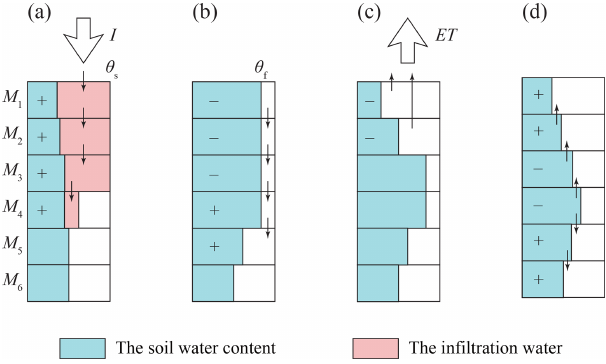
Figure A1. The schematic procedures of UBMOD with (a) the al- location of the infiltration water, (b) the soil water advective move- ment driven by the gravitational potential, (c) the source/sink terms, and (d) the soil water diffusive movement driven by the matric po-